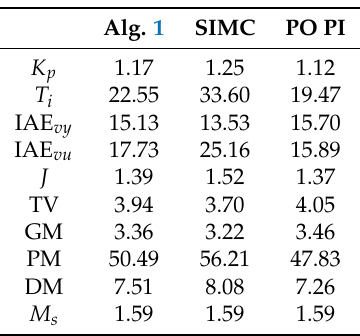
Table 8. Example 3. The table shows the PI controller parameter, indices and margins are given for prescribed robustness M s =